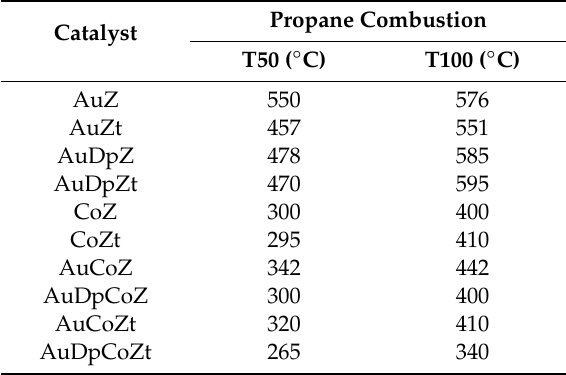
Figure 8. Results of propane conversion to CO 2 of tetragonal zirconia-supported catalysts ( ∆ ) CoZt, ( (cid:78) ) AuZt, ( (cid:4) ) AuCoZt, (– (cid:78) –) AuDpZt, (– (cid:4) –) AuDpCoZt. Table 4. T50 and T100 obtained with catalysts in propane combustion.